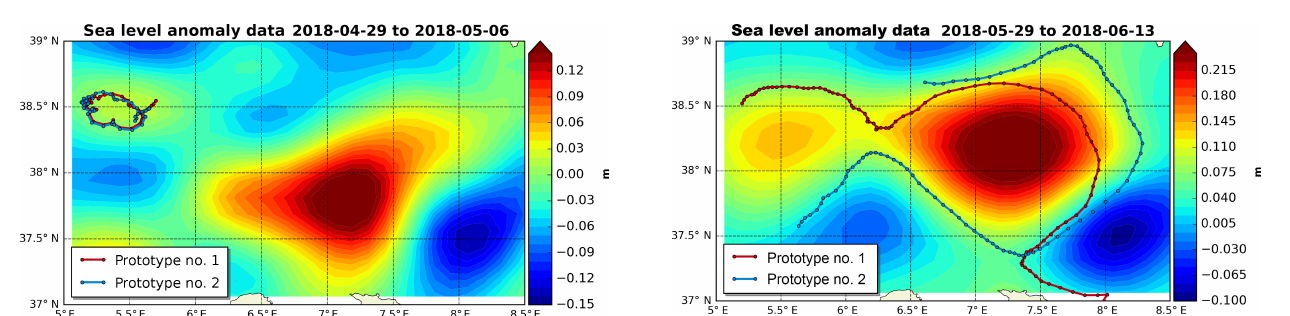
Figure 10. Mean sea level anomaly map with the two SVP-BRST prototypes’ tracks overlaid (prototype no. 1 in red, prototype no. 2 in blue) for the time period 29 April to 6 May 2018.